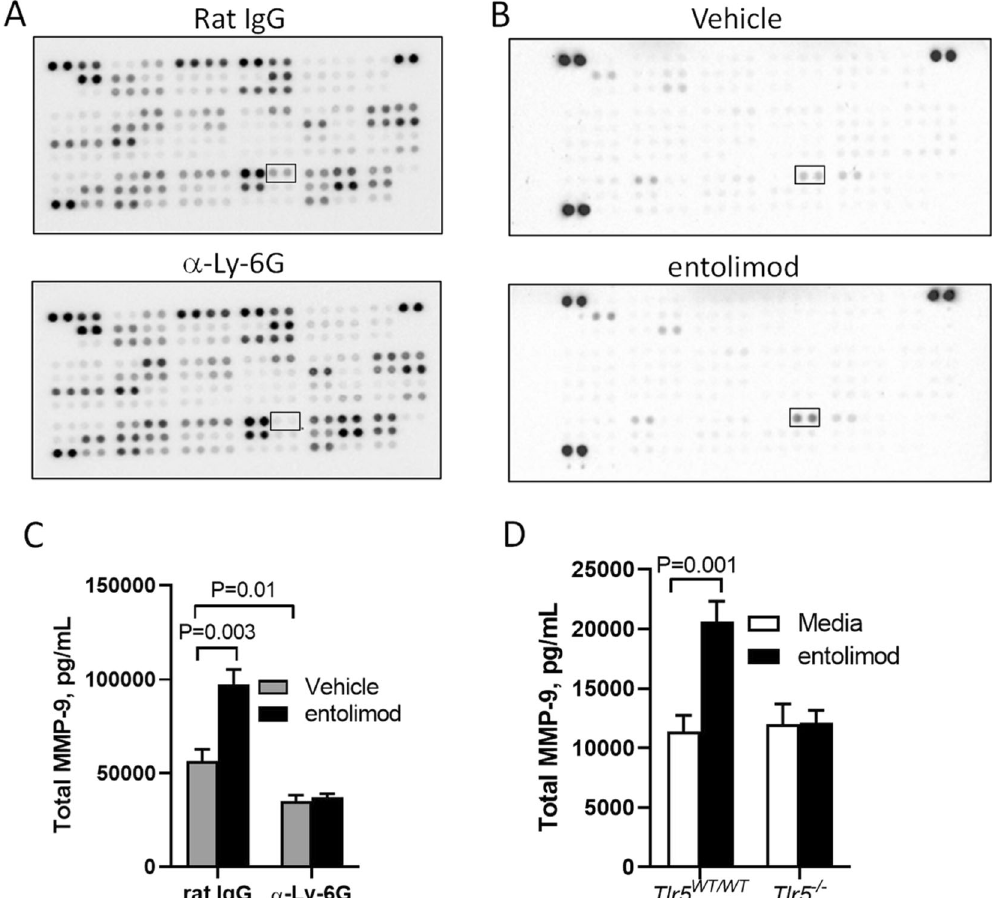
Fig. 4 Entolimod stimulates N ϕ to release MMP-9. Protein microarray analysis of A mouse serum using R&D Systems Proteome Pro fi ler Mouse XL Cytokine Array in the presence (rat IgG) and absence ( α -Ly-6G) of N ϕ 24 h post-TBI and B N ϕ isolated from BM that were ex vivo treated with vehicle or entolimod for 30 min. Measurement by ELISA of MMP-9 in C serum from mice ( n = 5/group) in the presence (rat IgG) and absence ( α -Ly-6G) of N ϕ 2 h post-treatment with vehicle or entolimod (TBI was delivered 24 h prior to vehicle or entolimod) and D supernatants from Tlr5 WT/WT and Tlr5 − / − N ϕ isolated from BM ( n = 6 mice/group) and ex vivo treated with vehicle or entolimod for 30